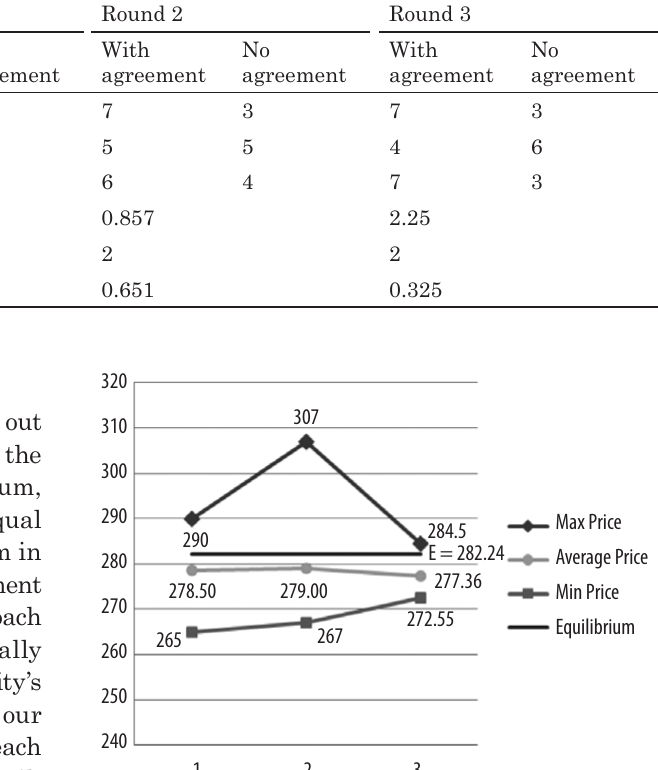
Table 4. Final prices for each game Final prices of Game 1: incomplete information